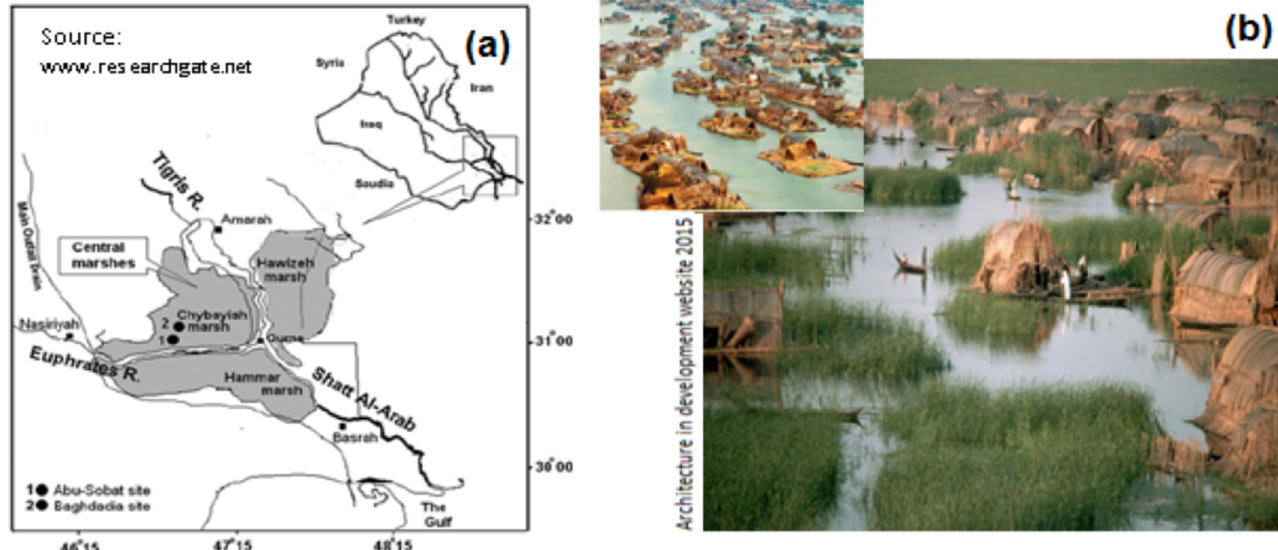
Fig. 1. Chibayish – Iraq: (a) Chibayish marsh location and (b) fl oating basket homes in